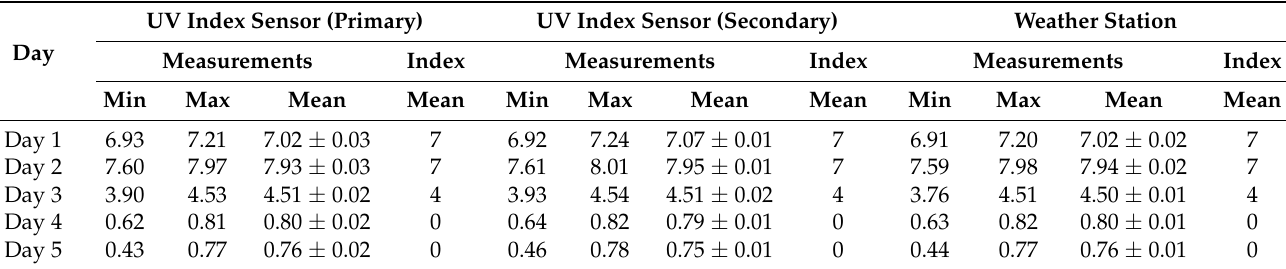
Table 5. Statistics of UV index